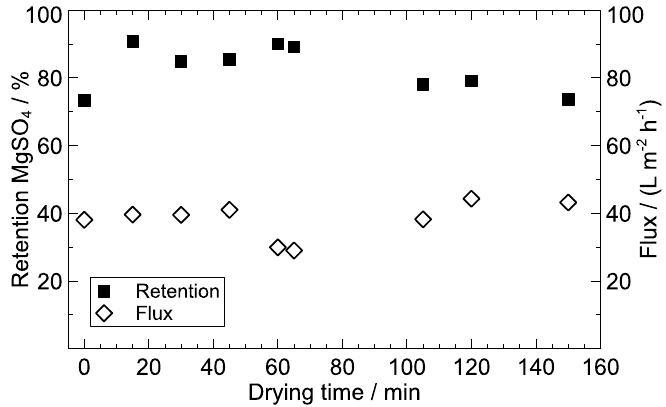
Figure 5. Effect of the drying time on the performance of composite MCM; aqueous amine solution: 0.4 wt % PIP, 0.15 wt % TEA; organic solution: 0.15 wt % TMC; ratio PIP/TMC = 12.5; feed solution: 3000 mg L − 1 MgSO 4 ; TMP = 2 bar.